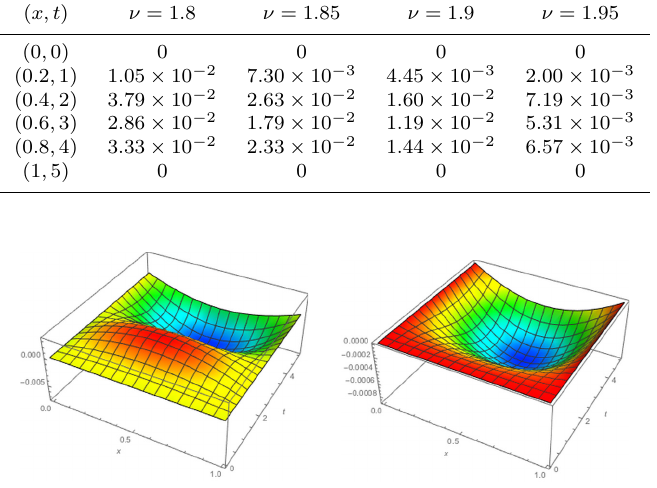
Figure 1. The absolute errors of ν = 1 . 75 (left) and ν = 1 . 95 (right) with β = 0 . 5 and M = 4 ,N = 4 on the interval [0 , 1] × [0 , 5] of Example 2.